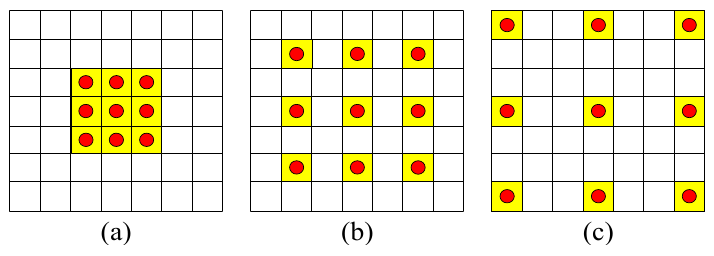
Figure 3. Dilated convolution: ( a ) rate = 1; ( b ) rate = 2; ( c ) rate = 2.